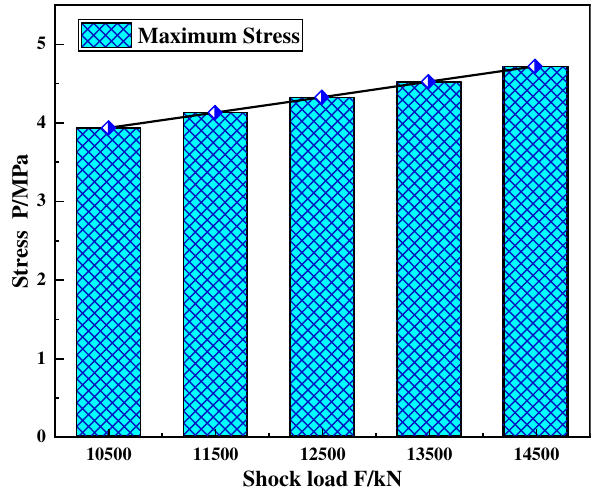
Figure 6. The maximum stress of the foundation node under different shock force.